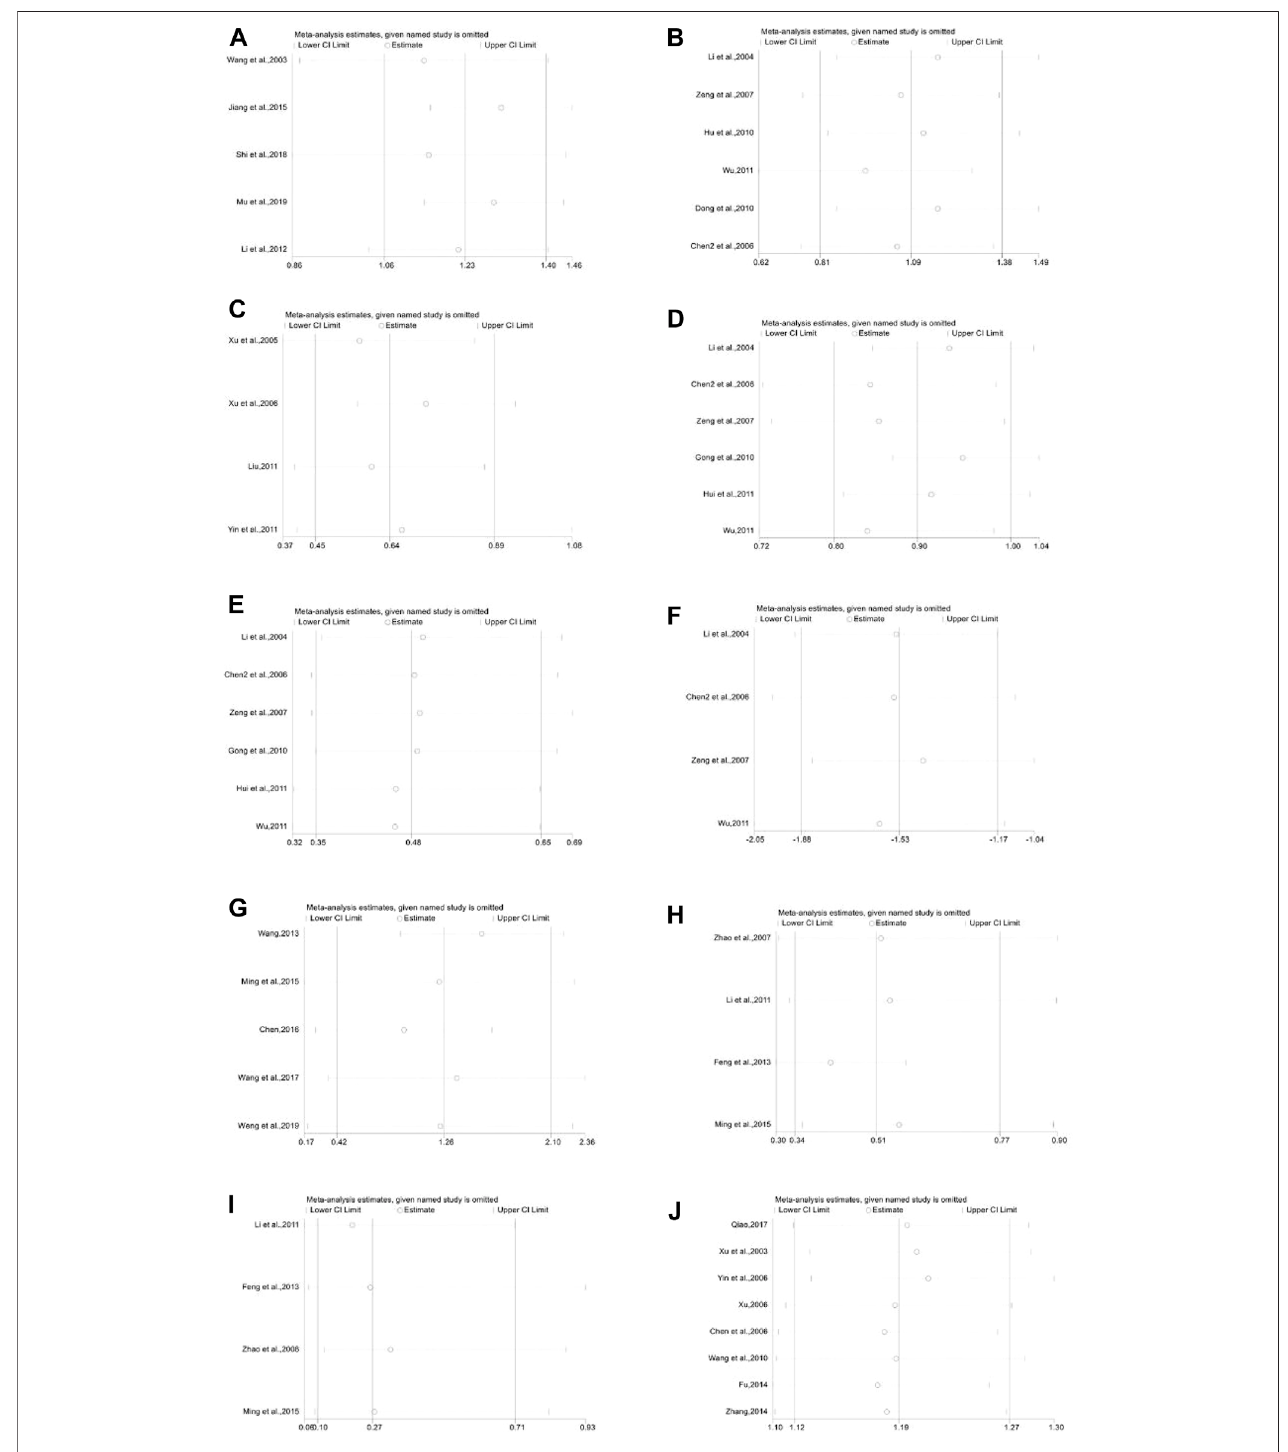
FIGURE 17 | Sensitivity analysis plot. (A) : White blood cell count of subgroup 1 in preventive medication, (B) : White blood cell count of subgroup 3 in preventive medication, (C) :Whitebloodcellsuppressionrateofsubgroup2inpreventivemedication, (D) :Whitebloodcellsuppressionrateofsubgroup3inpreventivemedication, (E) :III-IVdegreewhitebloodcellsuppressionrateofsubgroup3inpreventivemedication, (F) :ApplicationamountofG-CSF, (G) :Whitebloodcellcountofsubgroup3in therapeutic medication, (H) : White blood cell suppression rate of subgroup 3 in therapeutic medication, (I) : III-IV degree white blood cell suppression rate of subgroup 3 in therapeutic medication, (J) : White blood cell effective rate of subgroup 2 in therapeutic medication.